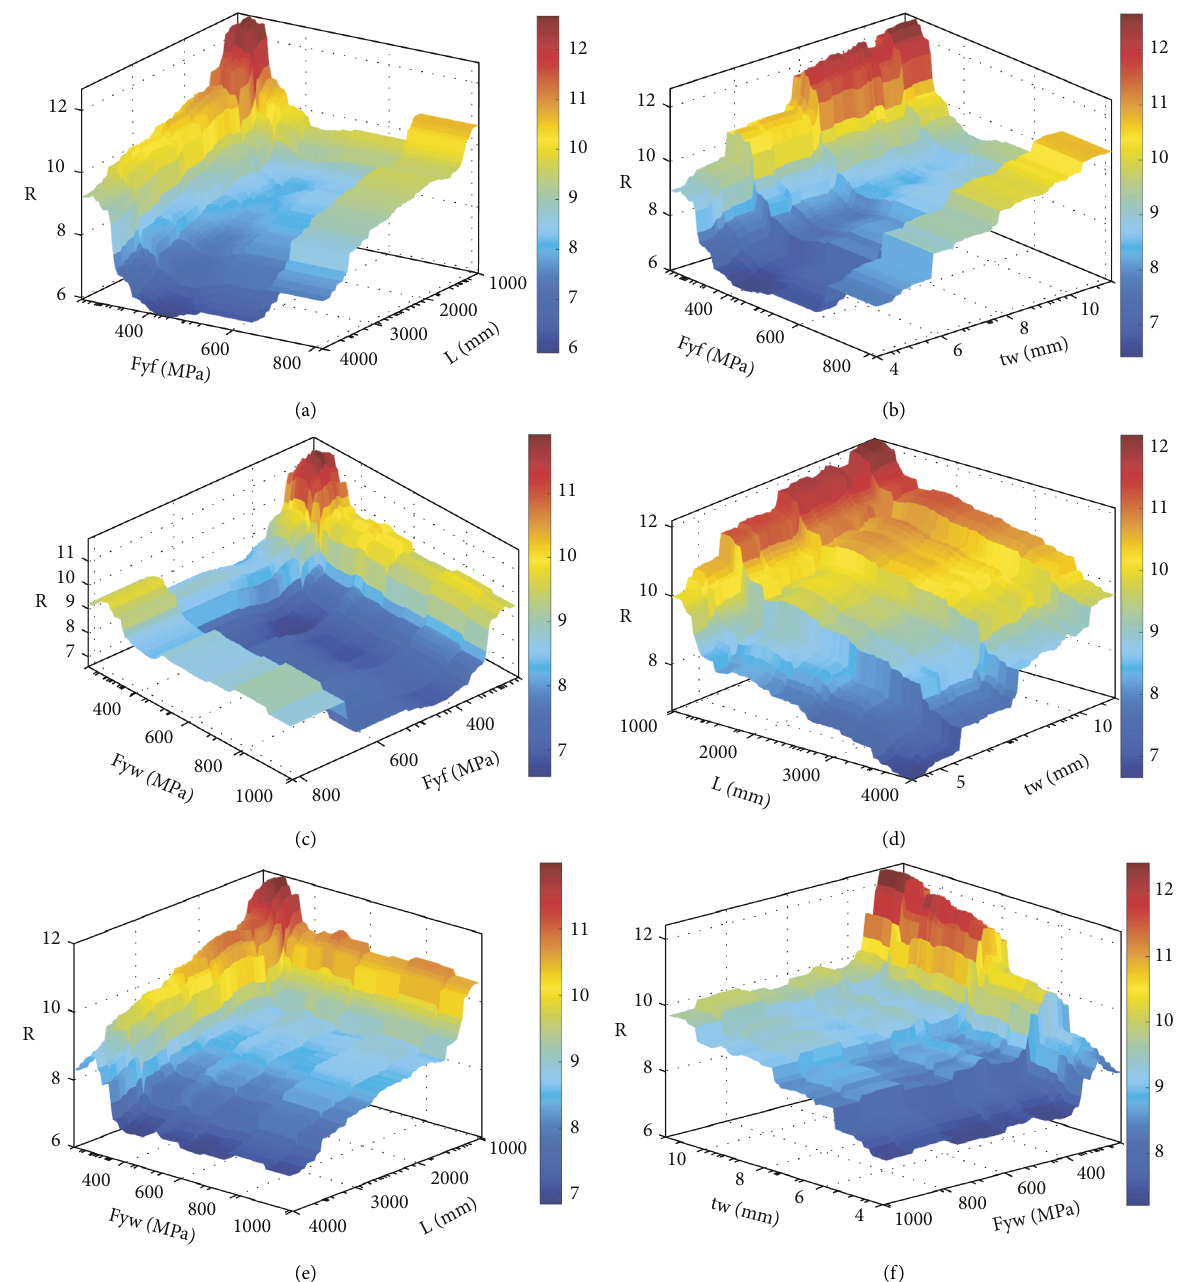
Figure 11: 2D-PDP analysis showing the relationship between input and output parameters considered in this